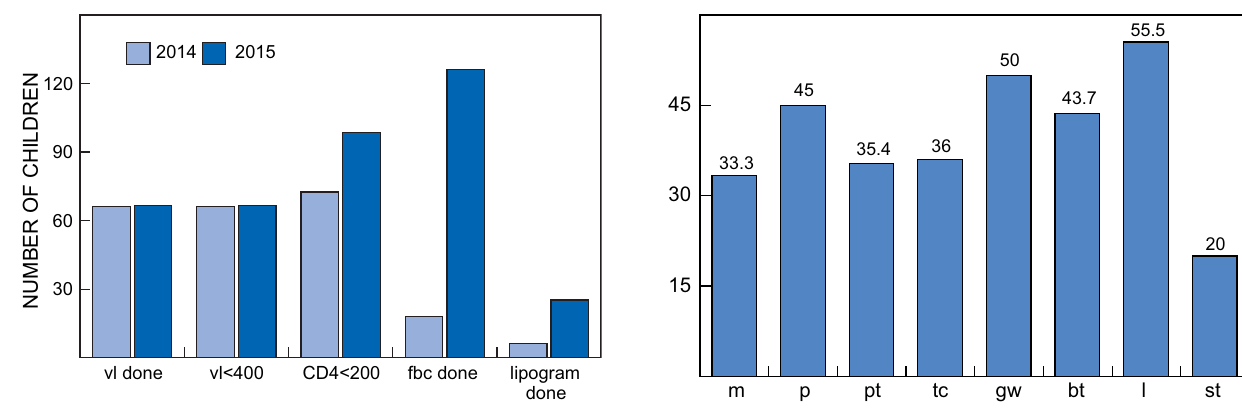
Figure 3: Monitoring and outcomes of children on ART in the district (2014 and 2015).